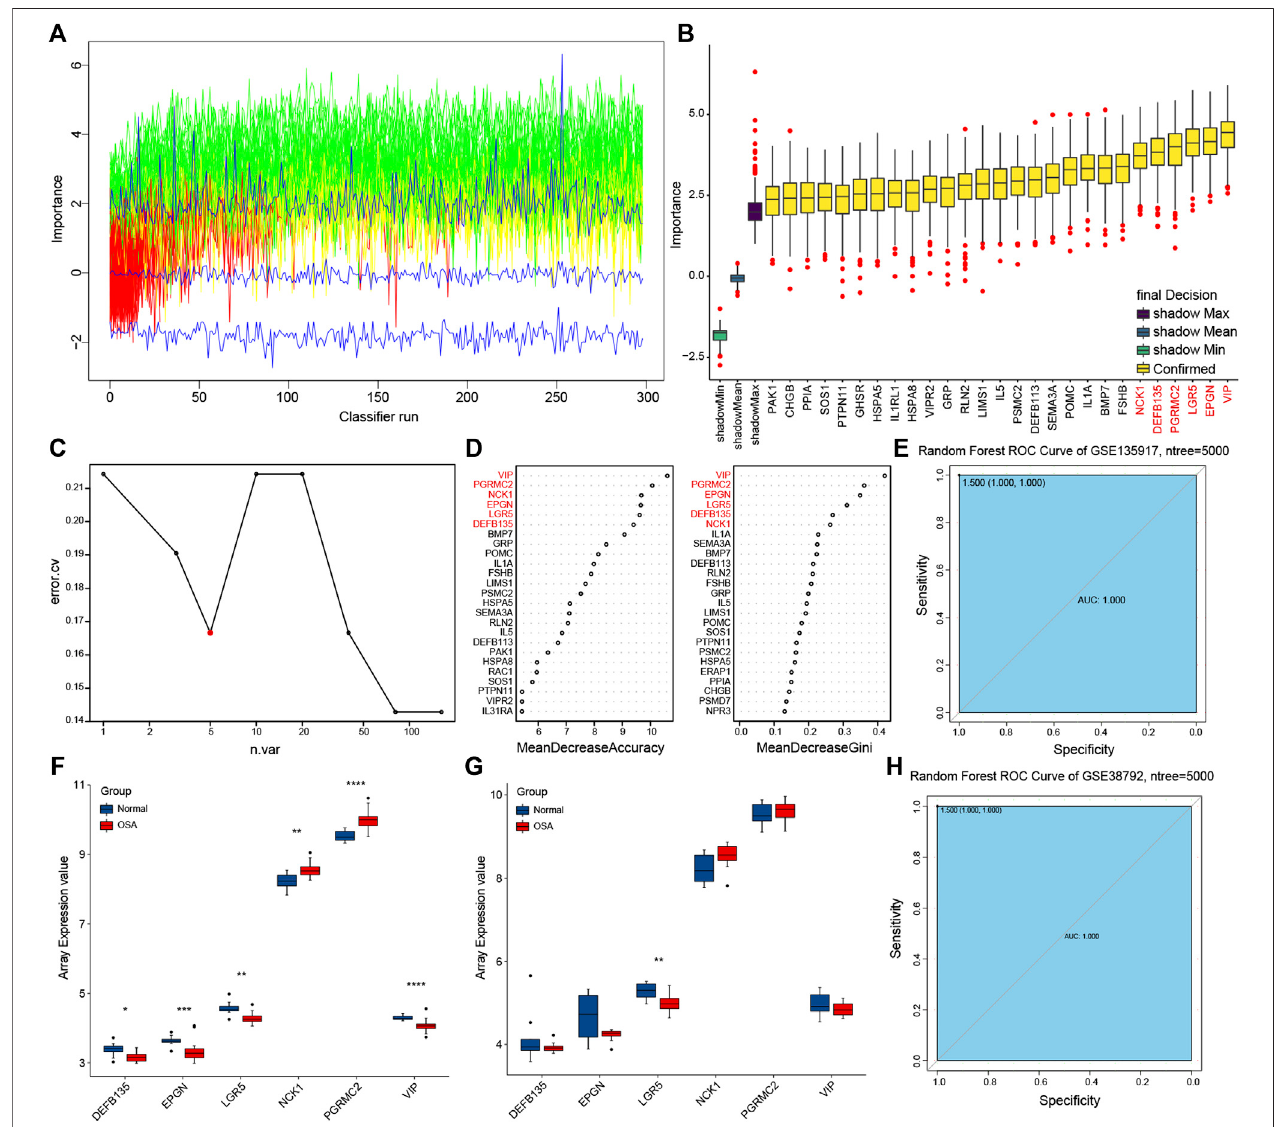
FIGURE7| Prognosticmodelbuildingandvalidation. (A) ThezscoreevolutionwithBorutarun. (B) SelectedgenesbyBorutaalgorithm. (C) Theaverageerrorrate of random forest model. (D) Variable importance ordered by accuracy and the gini index of a mean decrease in random forest. (E) Receiver operating characteristic (ROC)curvewithareaunderthecurve(AUC)valuesforGSE135917. (F) TheexpressionofpredictorsinGSE135917. (G) TheexpressionofpredictorsinGSE38792. (H) ROC curve with AUC values for GSE38792.